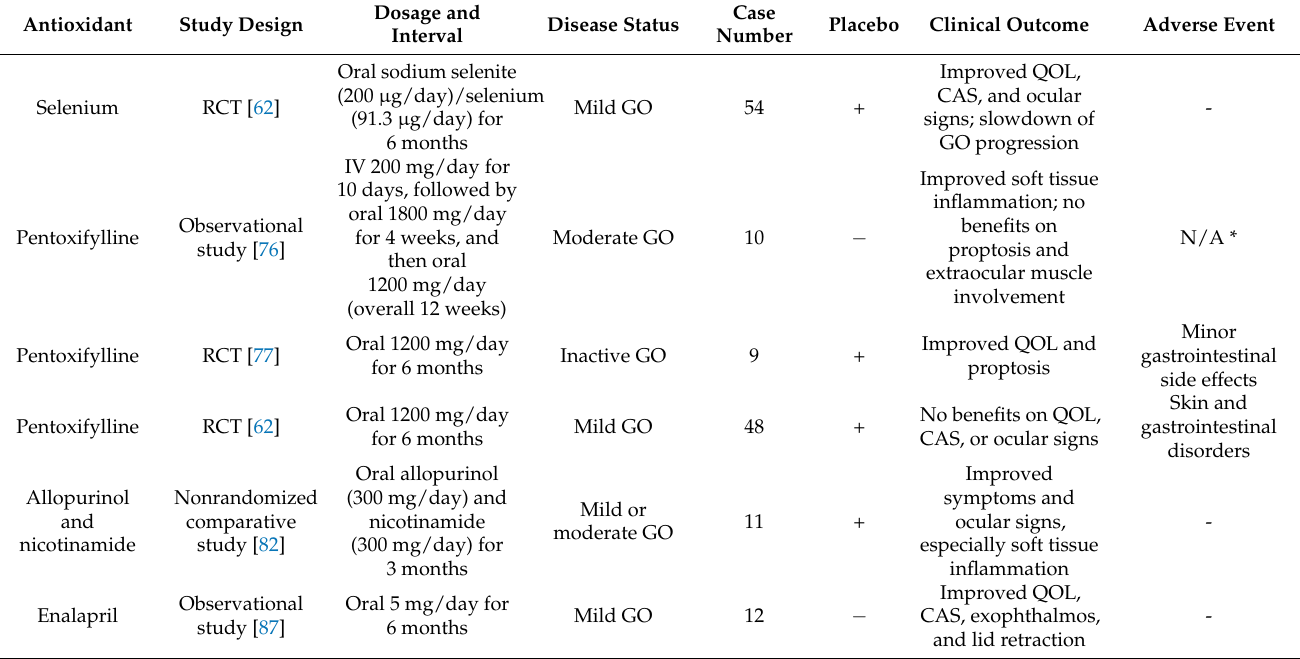
Table 1. Clinical studies on the efficacy of antioxidants in Graves’